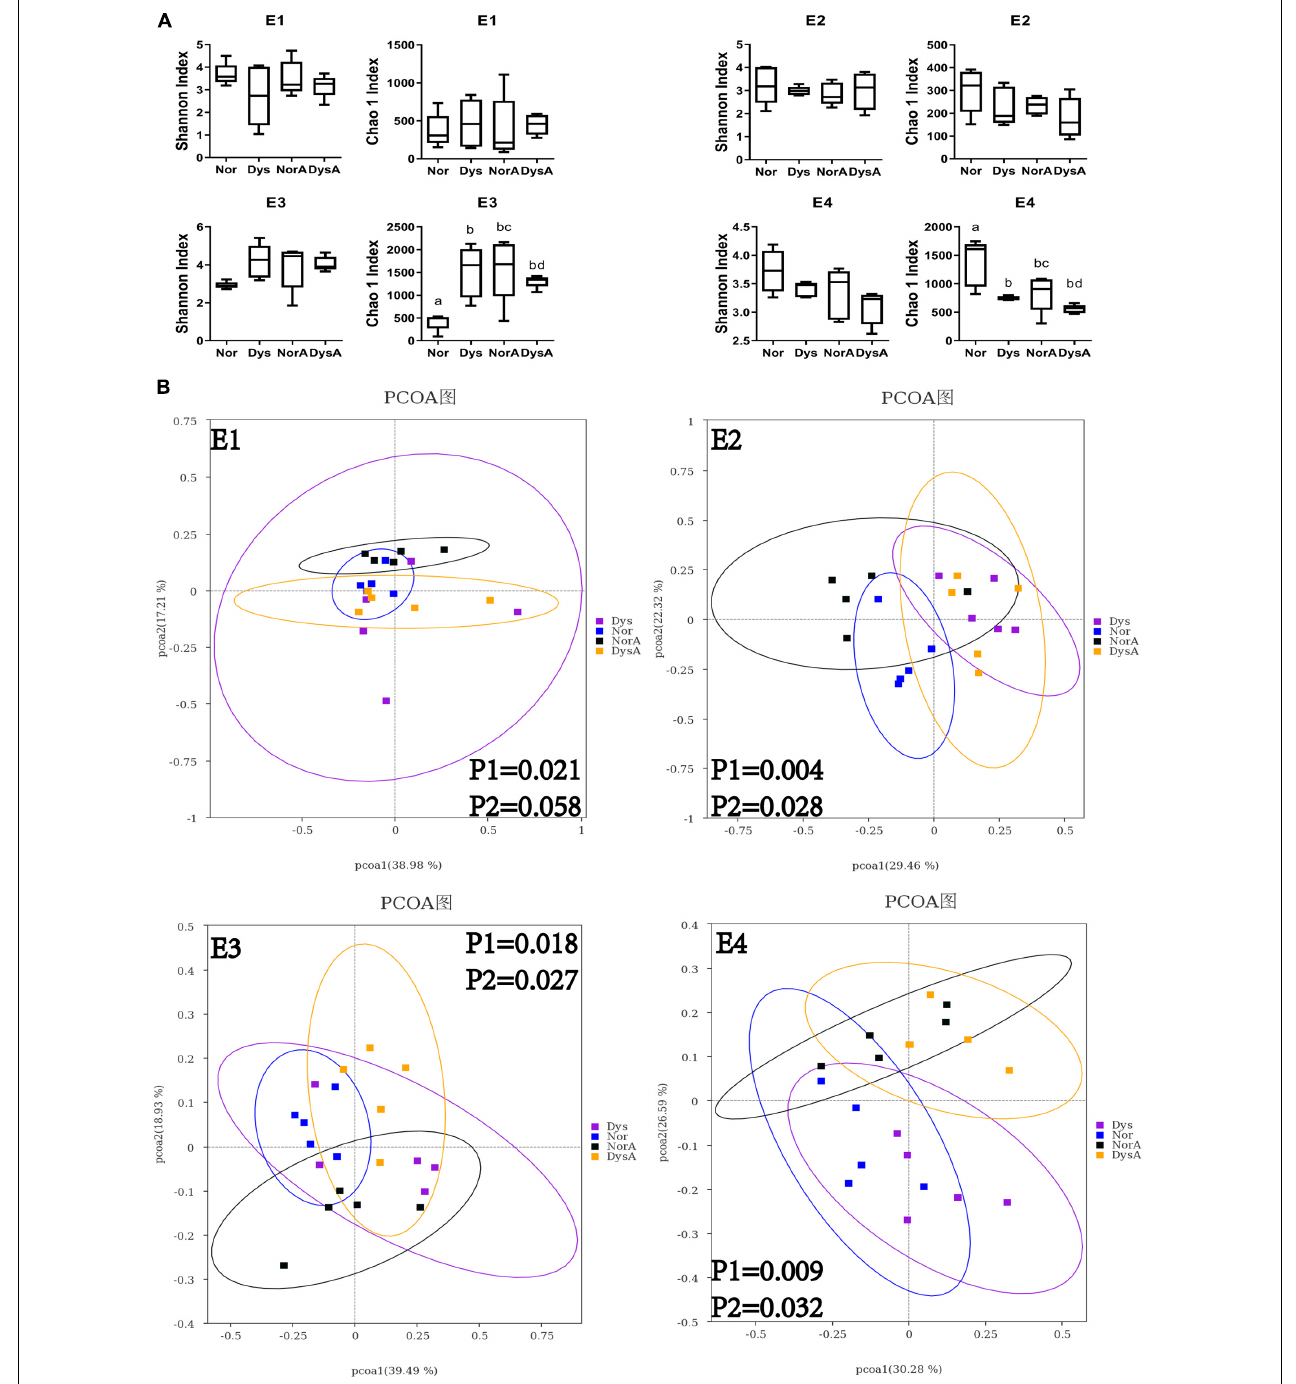
FIGURE 4 | Alpha and beta diversity of Nor, Dys, NorA and DysA honey bee workers. (A) Difference in alpha diversity between Nor, Dys, NorA and DysA workers measured using Shannon index and Chao 1 index. (B) The principal coordinate analysis (bray-Curtis) in gut community between Nor, Dys, NorA, and DysA workers. E1–E4 represent four experimental replicates with four different